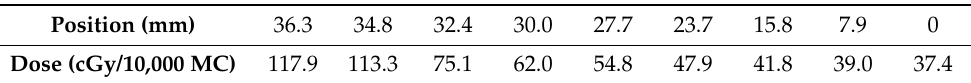
Figure 6. ( a ) 2D view of fibre sensitivity with wavelength at various positions along the proton track; ( b ) 3D view of fibre sensitivity with wavelength at different water depths showing the typical shape of the Bragg peak. Table 4. Estimated dose conversion for the proton spectra for 10,000 MC to cGy at each position (characterization from the Markus